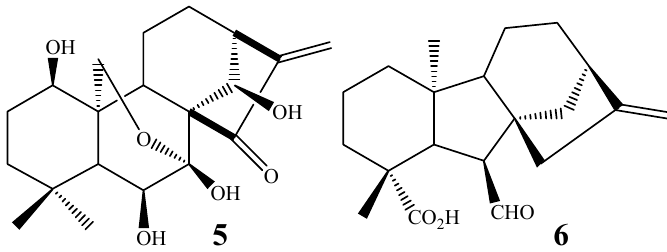
Figure 3. Chemical structures of compounds 5 and 6